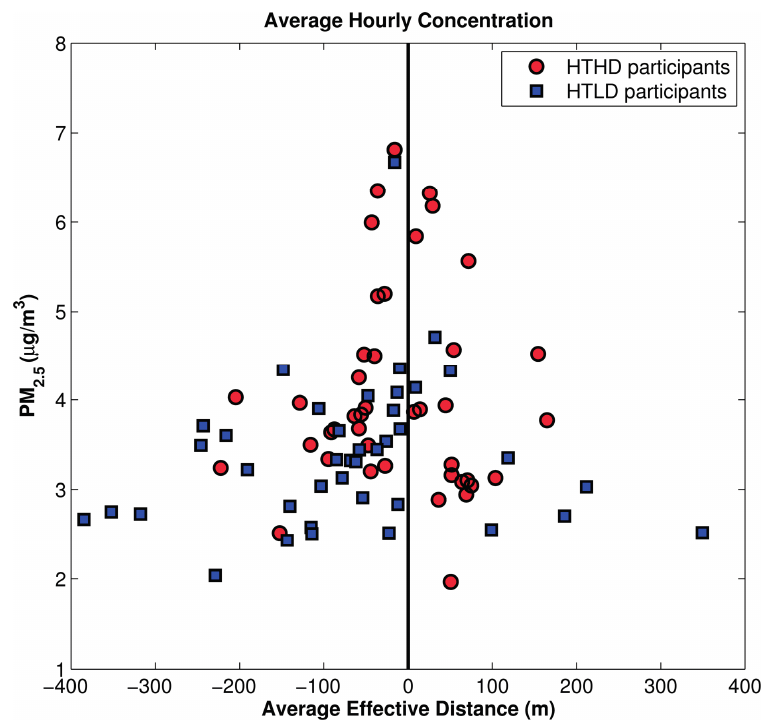
Figure 9. Average hourly concentration for PM HTLD